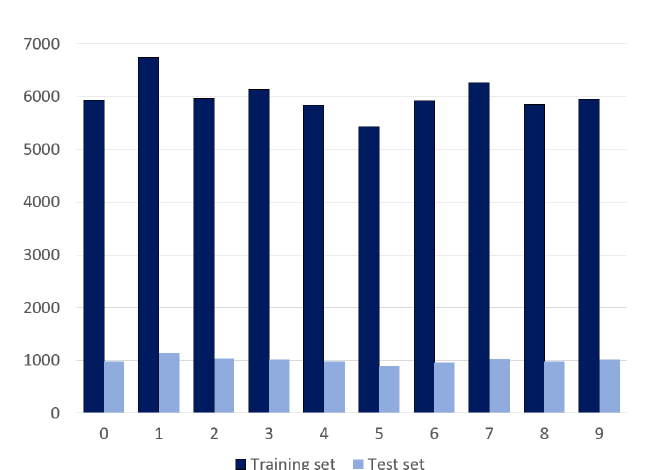
Figure 3 – Distribution of the digits in the MNSIT dataset Рис. 3 − Распределение цифр в наборе данных MNSIT Слика 3 – Дистрибуција цифара у МНИСТ скупу података